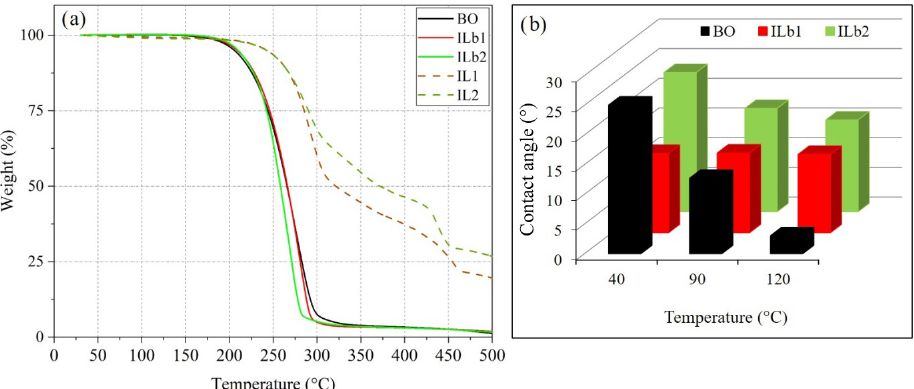
Fig. 2 (a) Thermogravimetric behaviors of neat ILs, BO, and IL blends and (b) contact angles of BO and IL blends on bearing steel